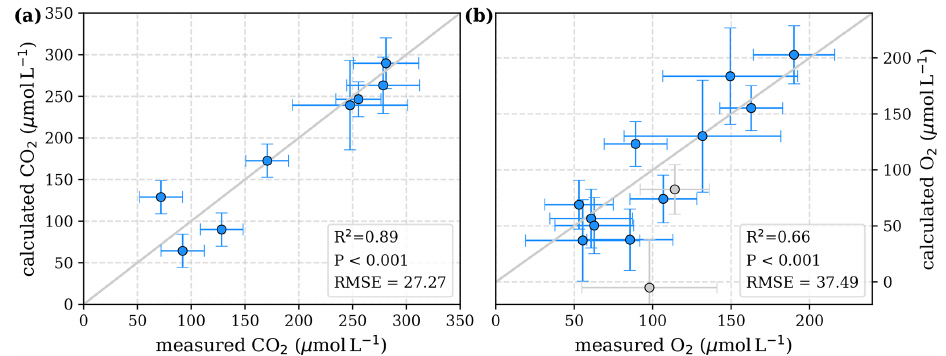
Figure D1. Correlation between measured and calculated concentrations of (a) CO 2 and (b) O 2 . Grey lines indicate the 1 : 1 line. Calculations were performed for exponential pH limitation without O 2 limitation. Each data point represents one river. Grey data points are excluded from the correlation since the data for these rivers are based on fewer than three campaigns within the same season.